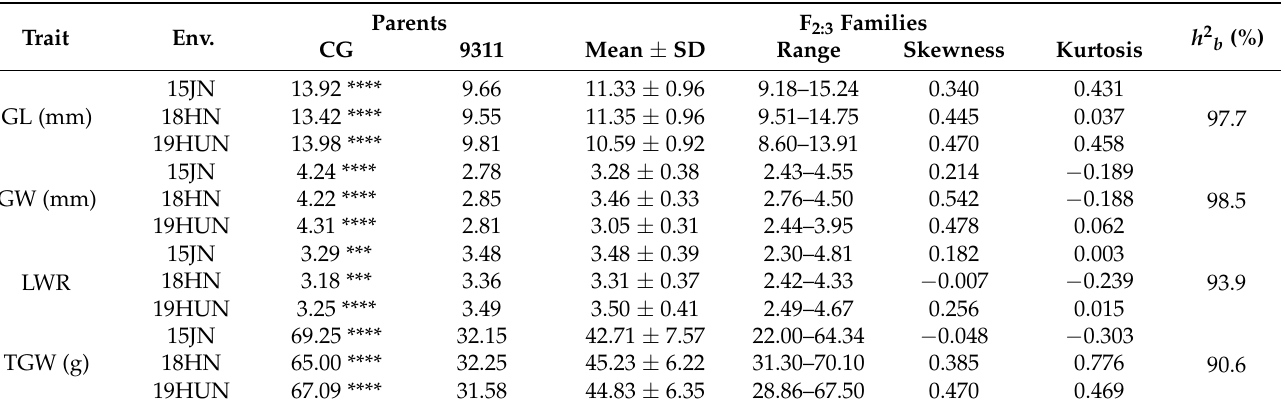
Table 1. Phenotypic values of grain size in F 2:3 populations.